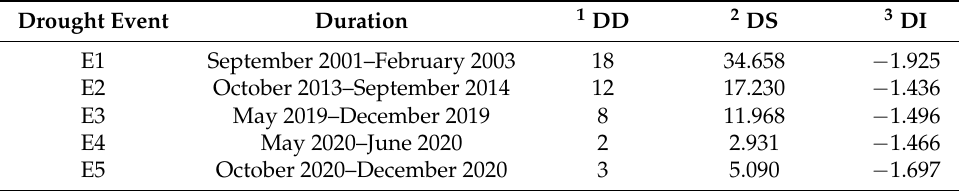
Table 7. Run theory identification results.